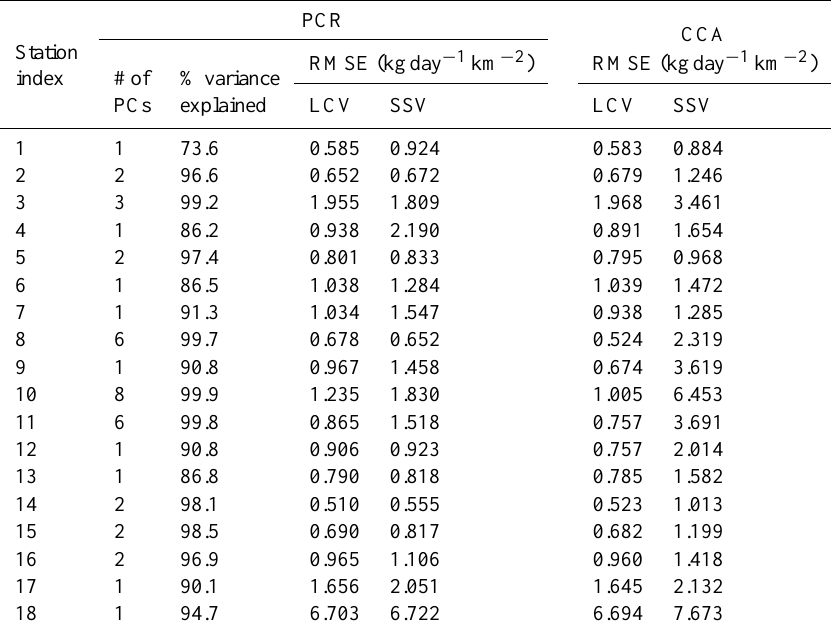
Table 4. Skill, expressed as root-mean-square error (RMSE) (based on Eq. 4), in predicting winter TN loadings using climate forecasts. Table also gives the number of principal components considered and the percentage variance explained by them for the total grid points selected (given in Table 3) for each